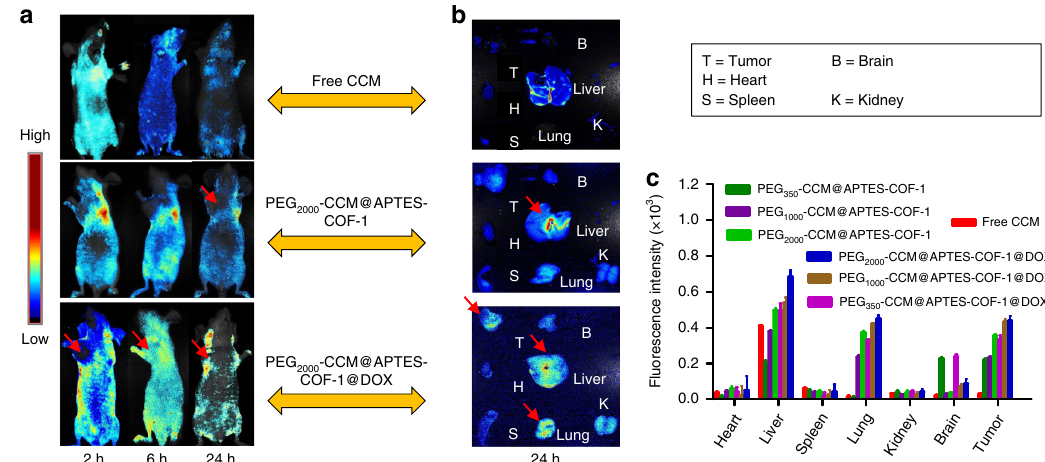
Fig. 7 Fluorescence imaging and fl uorescence intensity characterizations. a Ex vivo fl uorescence images (ex: 455 nm) and b in vitro fl uorescence images of major organs and tumors of mice after intravenous injection of PEG 2000 -CCM@APTES-COF-1, PEG 2000 -CCM@APTES-COF-1@DOX over a period of 24 h. c Mean CCM fl uorescence intensities of major organs and tumor at 24 h after administration. Tail injection into the HeLa tumor-bearing mice was at a single sample dose of 5 mg kg − 1 in PBS (3 mice/group). Each data point represents the average and SD (one above and one below for the error bars) as measured from fi ve different analysis in a single experiment